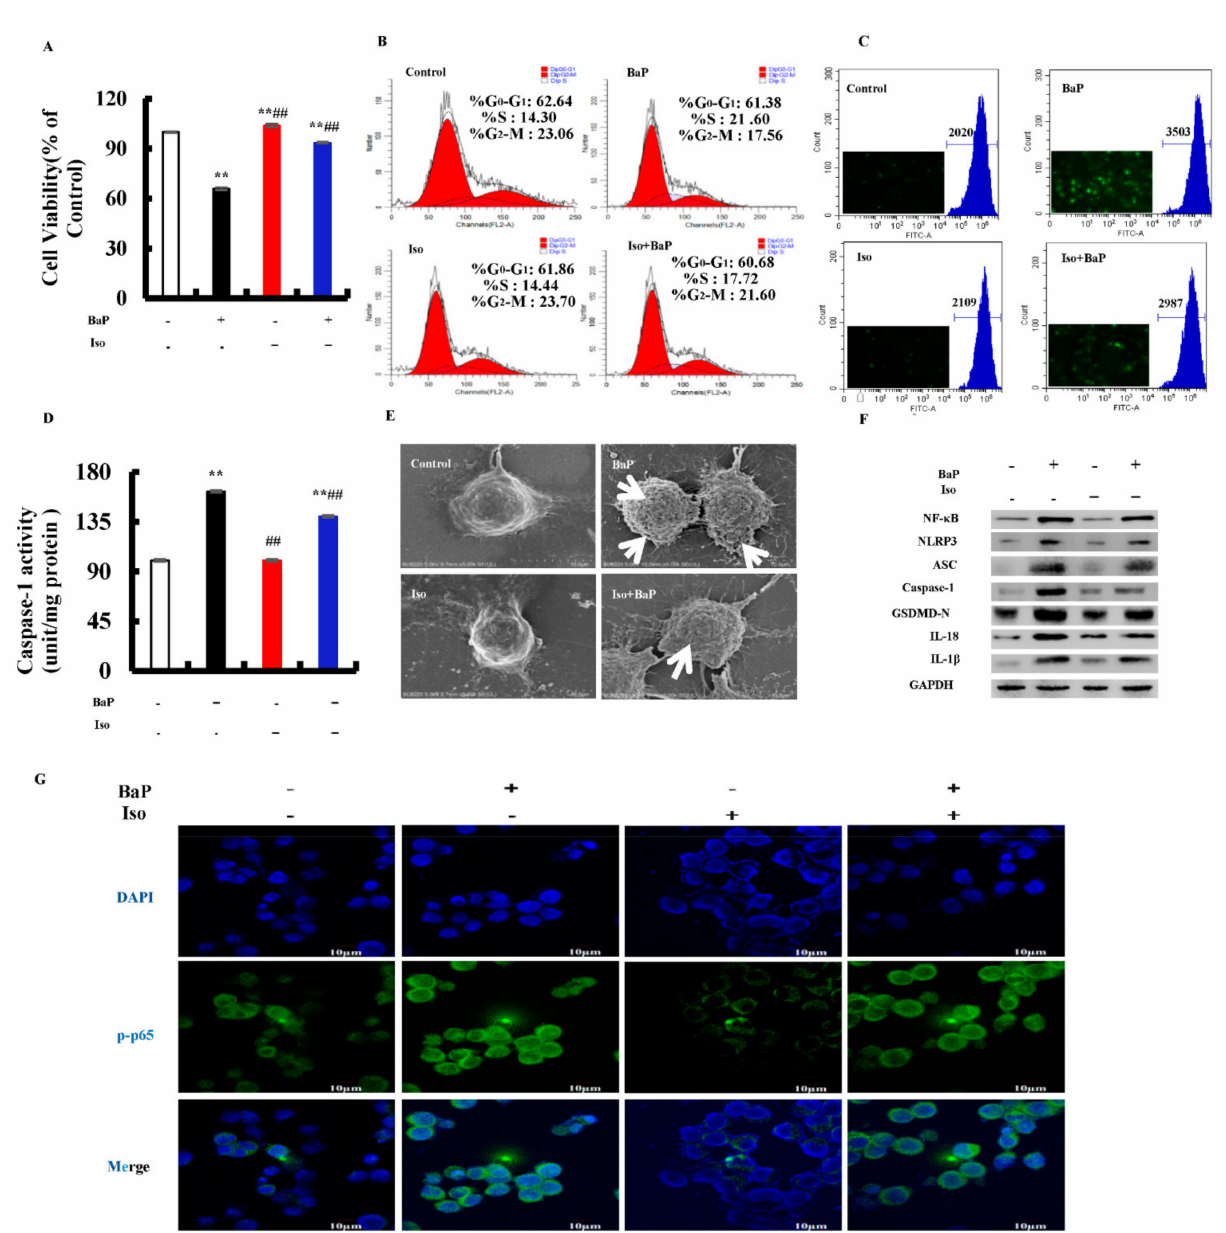
Figure 7. Effects of Iso (5 µ M) on the pyroptotic hepatocyte damage induced by BaP (25 µ M). Cell viability ( A ), cell cycle ( B ), ROS levels ( C ), and Caspase-1 enzyme activity ( D ) were detected. ** p < 0.01 compared with control, ## p < 0.01 compared with 25 µ M BaP. Scanning electron microscope observation of membrane pores; white arrows indicate the membrane pore ( E ). Western blot image of protein expression acquired by Chemical XRS Imaging System ( F ). Nuclear translocation of phosphorylated p65 was observed by immunofluorescent labeling with DAPI (blue) and anti-phosphorylated p65 (green) ( G